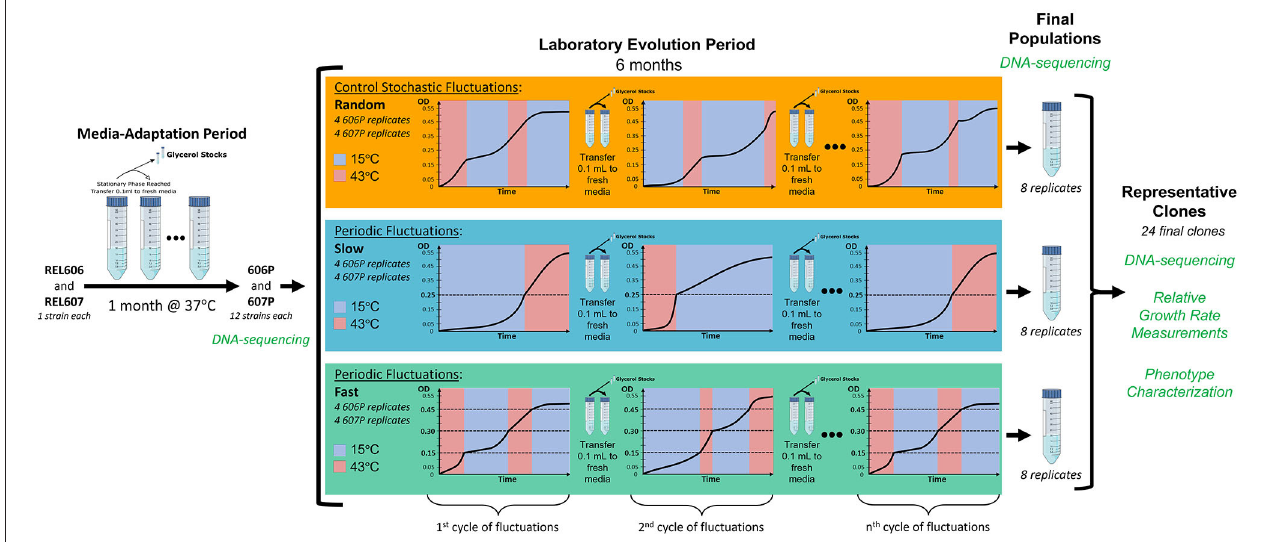
FIGURE 1 | Schematic of our laboratory evolution experiment in fluctuating environments. Dashed lines represent the optical densities when temperatures where switched in the periodic treatments. To ensure similar times are spent in each growth curve phase for each of the two temperatures we are fluctuating between, the fluctuation regimes start a new cycle at the temperatures they were transferred from in the previous cycle. In other words, we alter which temperature each fluctuation cycle begins